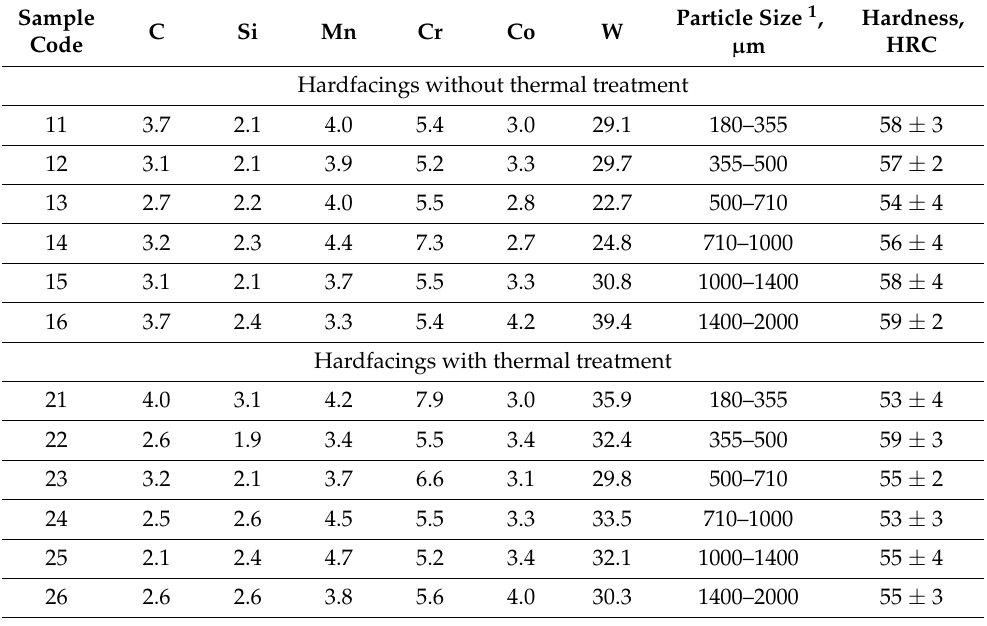
Table 1. Chemical composition of hardfacings with reinforcing particles made from recycled inserts in